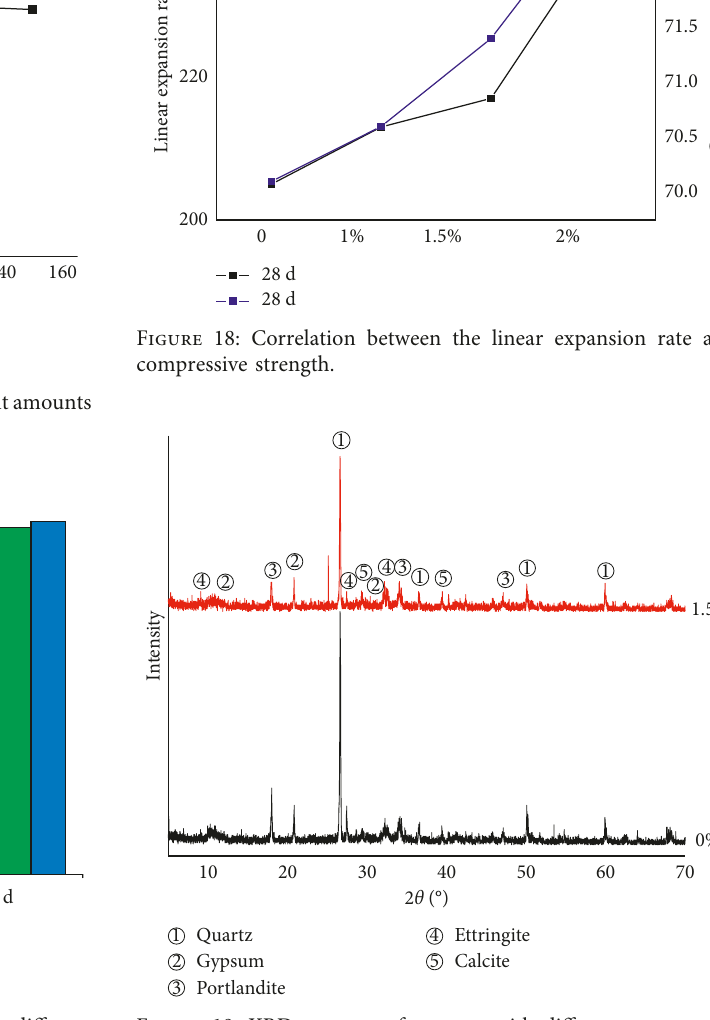
Figure 19: XRD patterns of mortars with different amounts of sodium sulfate at 3d